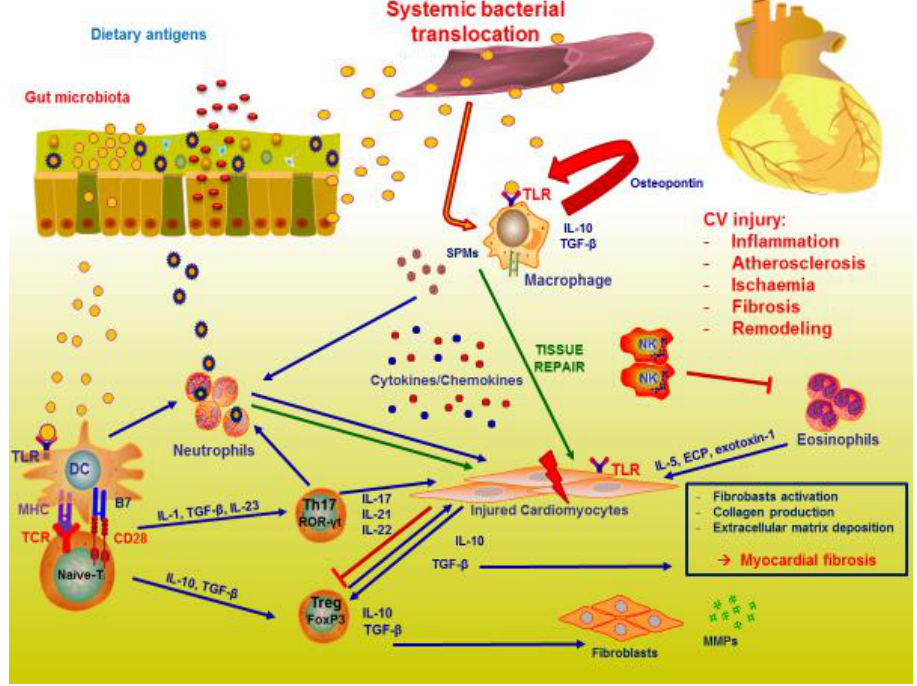
Figure 1. The complex interplay between gut microbiota and immunity in heart failure. A bidirec- tional interplay between gut microbiota and mucosal immunity occurs. In pathological condition, as consequence of bacterial translocation, innate and adaptive immune systems are activated, in- volving several cells, such as neutrophils, eosinophils, macrophages, dendritic cells, and T cells and their mediators. Cardiomyocytes are the final target of this complex activation of tissue inflamma- tion. Injured cardiomyocytes are in turn responsible of further perpetuation of inflammatory pro- cess and innate cells and fibroblasts participate to tissue repair and cardiac remodeling.